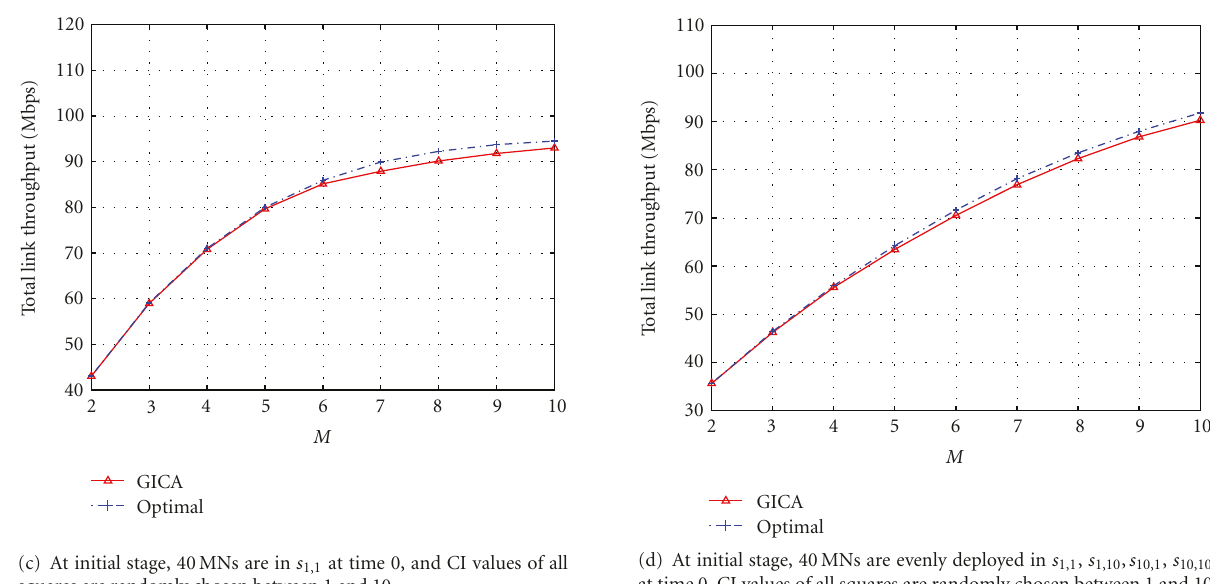
Figure 10: Average total link throughput over the entire relief process versus di ff erent number of RNs in four scenarios. r = 1 . 5 L , C =